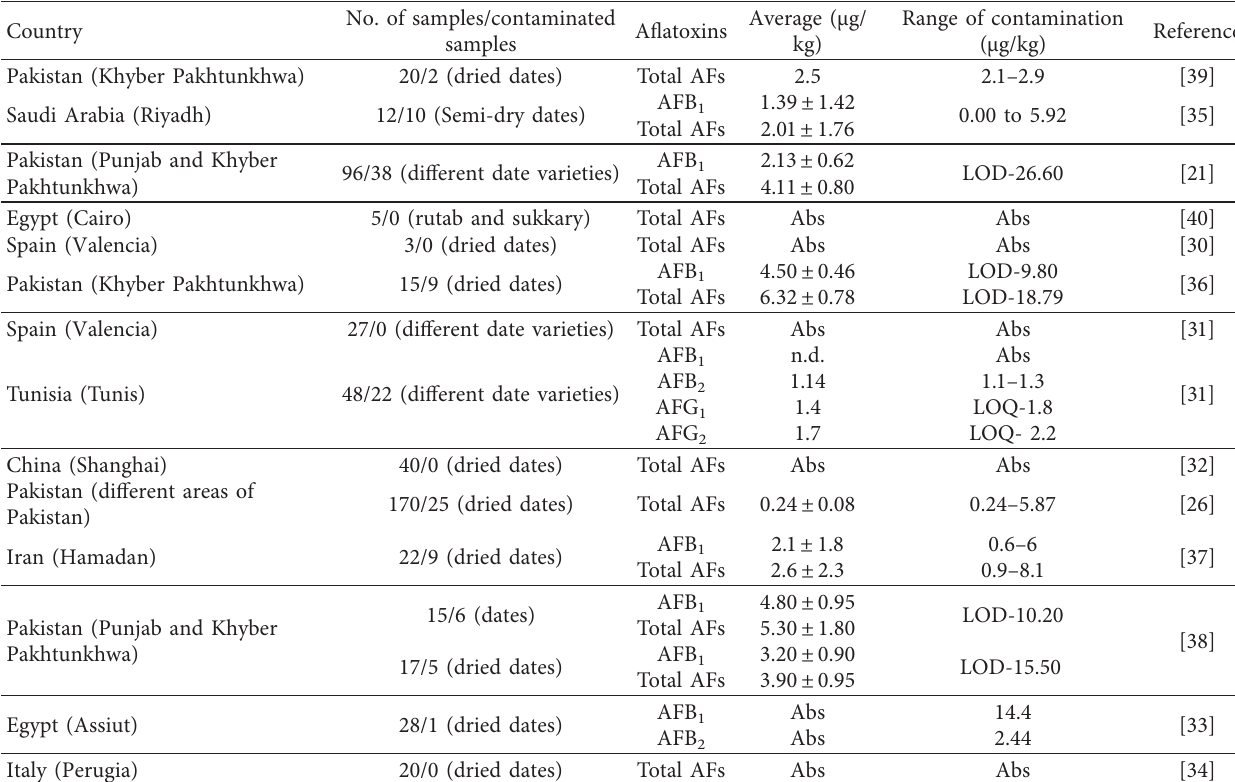
Table 3: The frequency and the incidence of aflatoxins contamination in dates in various world regions.